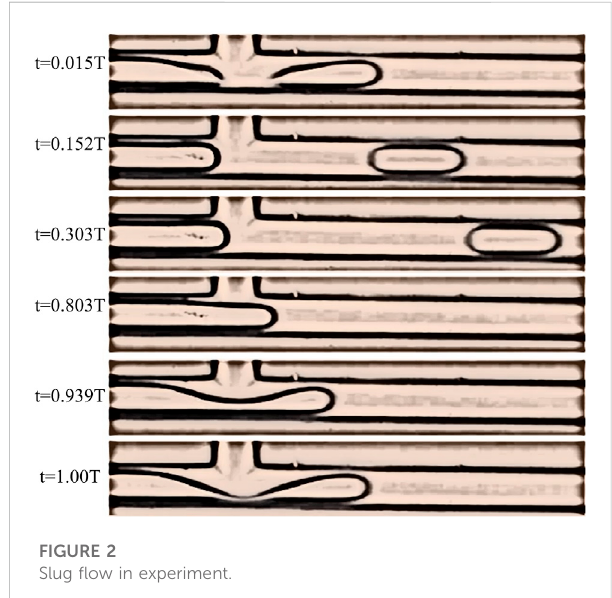
FIGURE 2 Slug fl ow in